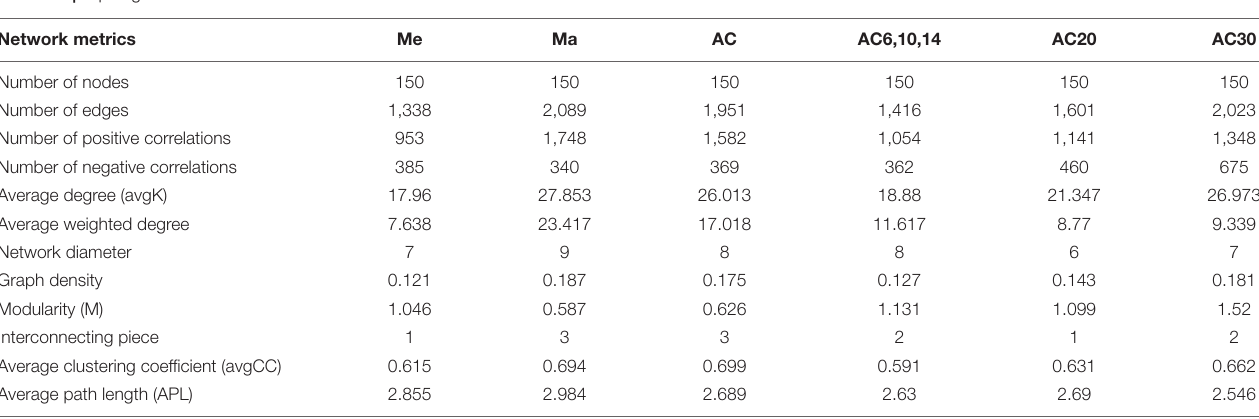
FIGURE 6 | Co-occurrence network of the soil bacterial community for Me (A) , Ma (B) , AC (C) , AC6, 10, 14 (D) , AC20 (E) and AC30 (F) treatment. TABLE 3 | Topological characteristics of soil bacterial co-occurrence